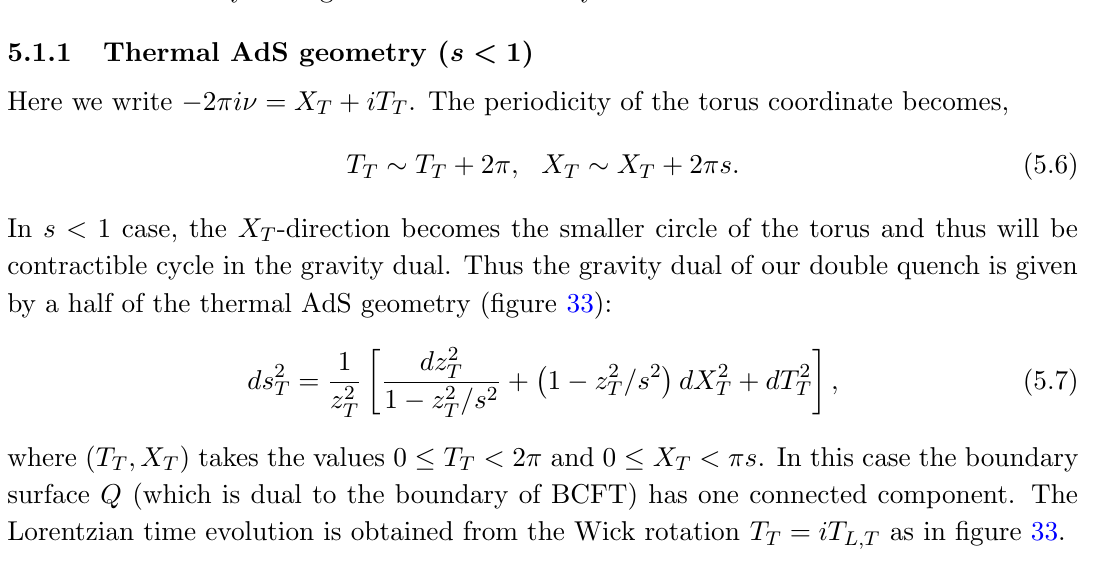
Figure 32 . The right (cid:12)gure describes \doubling" of (cid:23) annulus coordinate. Im( (cid:23) ) = identi(cid:12)ed, and also Re( (cid:23) ) = 0 ; 1 line are identi(cid:12)ed, which corresponds to the whole